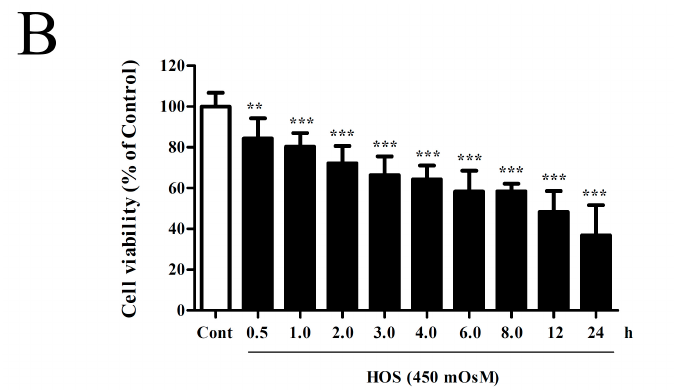
Figure 1. The effects of KIOM-2015EW or hyperosmolar stress (HOS) on cell viability in human corneal epithelial cells (HCECs). ( A ) HCECs were treated with the indicated dose of KIOM-2015EW for 24 h, and cell viability measured by MTT (3-(4,5-Dimethylthiazol-2-yl)-2,5-Diphenyltetrazolium Bromide) assay; ( B ) HCECs were exposed to 450 milliosmoles (mOsM) F-12/ Dulbecco’s Modified Eagle Medium (DMEM) serum-free media for the indicated time, and cell viability measured by cell counting kit (CCK)-8 assay. Data are representative of three independent experiments performed in triplicate. Data are summarized as mean ± standard deviation (SD) from three independent experiments. * p < 0.05, ** p < 0.01, and *** p < 0.001 vs. control.